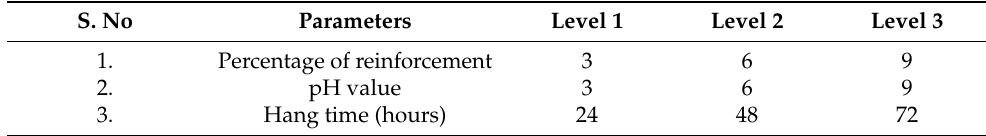
Table 5. Process variables and their levels (corrosion test).